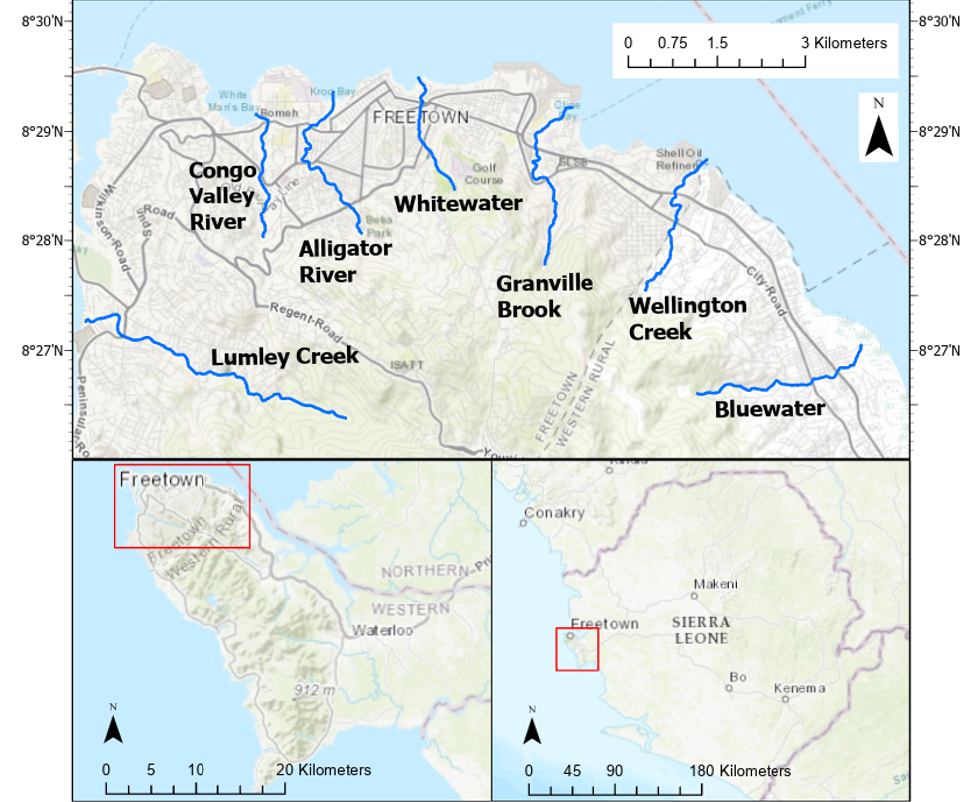
Figure 1. Study area for framework development: Western Area Peninsula, Sierra Leone .